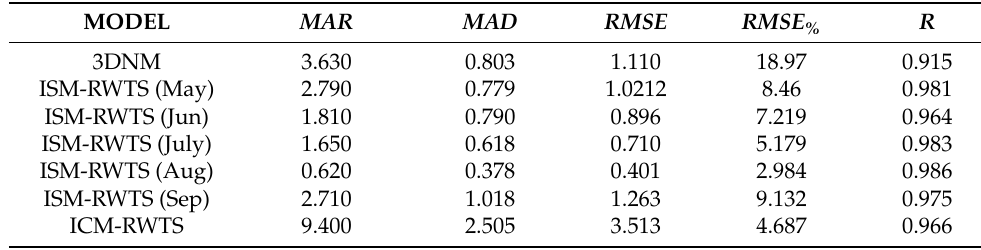
Table 3. Performance indicators of the various models.